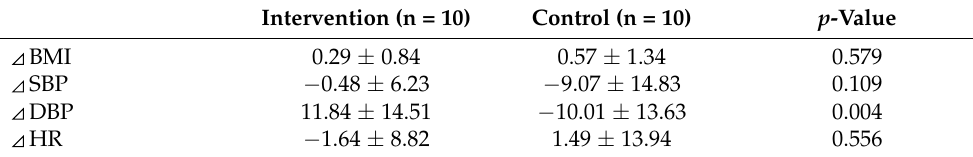
Table 2. Comparison of the changes in clinical characteristics after the exercise intervention program.